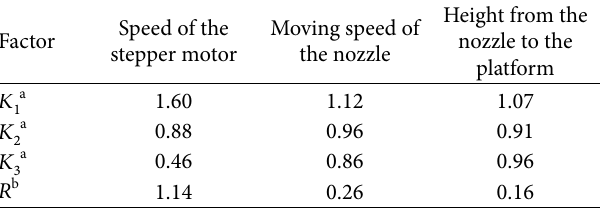
a 𝐾 𝐾 , 𝐾 represent the average diameter of the printed fibers correspond- 1 , 2 3 ing to the number i level of various factors ( 𝑖 = 1, 2, 3 ). b 𝑅 represents the range of the average of absolute value of